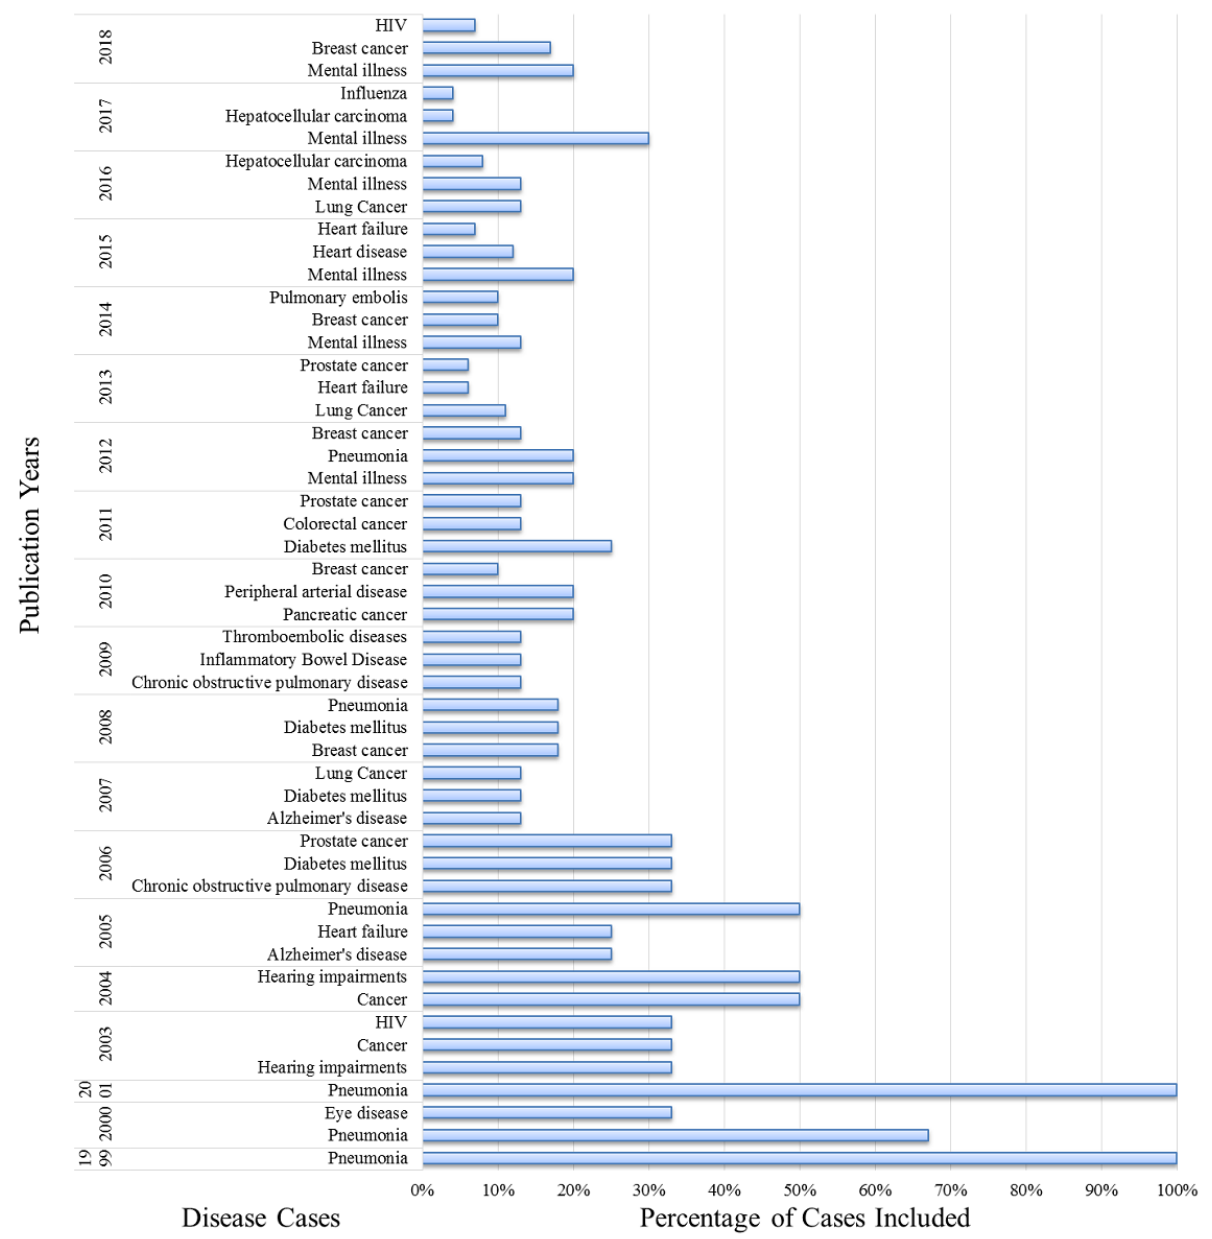
Figure 7. Temporal distribution of studies that used natural language processing for the investigation of disease cases (note: this figure shows the names of the top three diseases in studies that used natural language processing to investigate disease cases each year. Fewer than three disease types indicates that only one or two diseases were studied in the year. The term cancer in the figure indicates the article only mentioned the term cancer, without specifying the type of